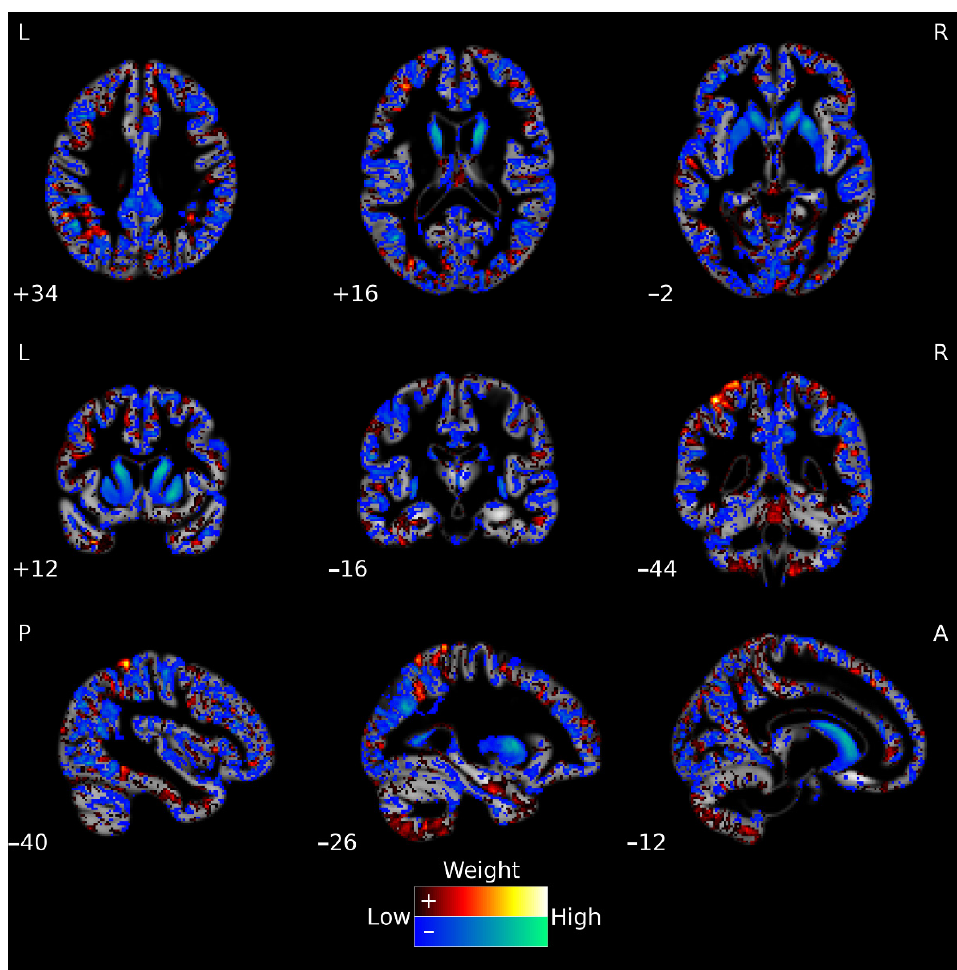
Figure 1. Voxels’ weights for the Early-HD vs. Pre-HD classification using whole-brain GM features. The hot (red-yellow) and cold (blue-green) color maps show the positive and negative weights, respectively. For visualization purposes, weight values at the lowest 10% range (closer to zero, positive, and negative) are not displayed. The ‘Low’ (closer to zero) and ‘High’ (further away from zero) descriptions refer to absolute weight values. The map is overlaid on a mean GM image, in grey scale, that was calculated using the participants from our study. L = left; R = right; A = anterior; P = posterior.